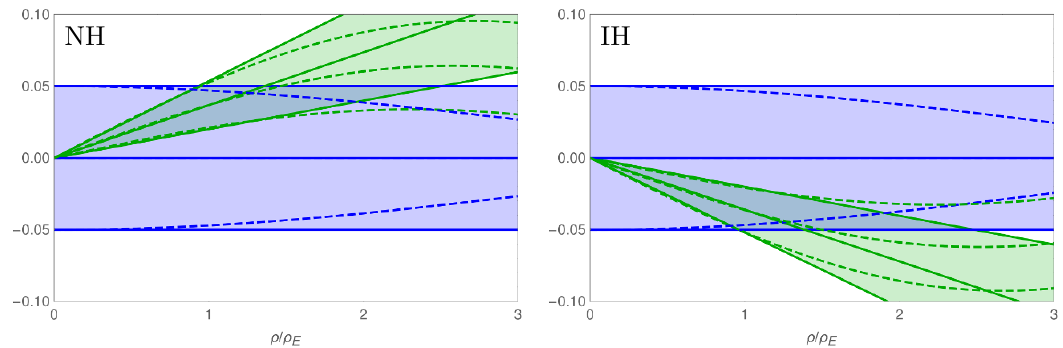
Figure 2 . CPT-odd (green) and T-odd (blue) components of A CP density (cid:26) in units of that of the Earth mantle, at (cid:12)xed ( E; L ) = (0 : 75 GeV ; 1300 km). Both the exact (dashed) and the analytical (solid) results from eqs. (3.18), (3.19) are shown. Normal Hierarchy in the left pannel, Inverted Hierarchy in the right pannel. The bands correspond to all possible values changing (cid:14) in (0 ; 2 (cid:25) ); the upper/central/lower lines for A CPT cos (cid:14) (sin (cid:14) ) = (cid:0) 1 ; 0 ;